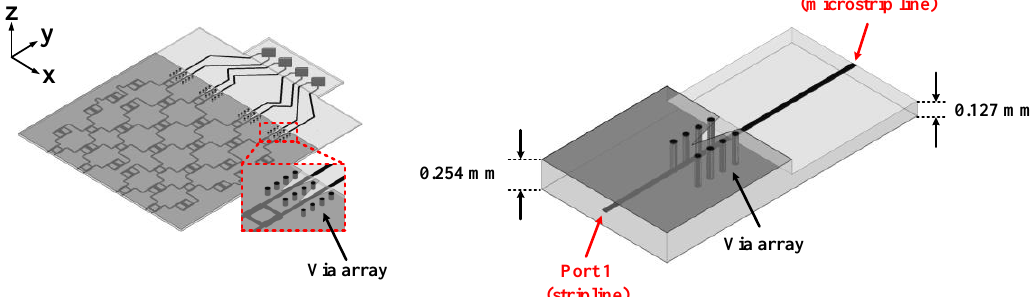
( b ) Figure 6. Simulated results of the 8 × 8 Butler matrix: ( a ) averaged insertion losses and ( b ) output phase for excitation of port 4. The configuration of the transition part to connect to the stripline-type Butler matrix with the microstrip patch antenna array is illustrated in Figure 7. The 0.17 mm widths of the stripline and